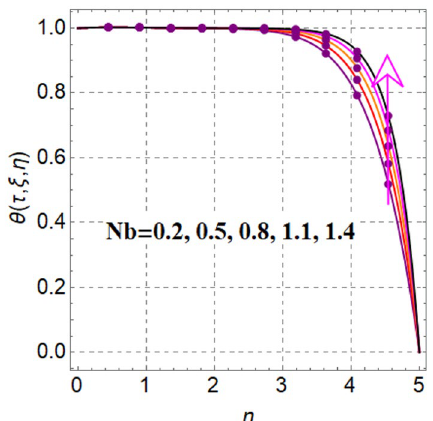
Figure 5. θ(τ , ξ , η) via Nb .